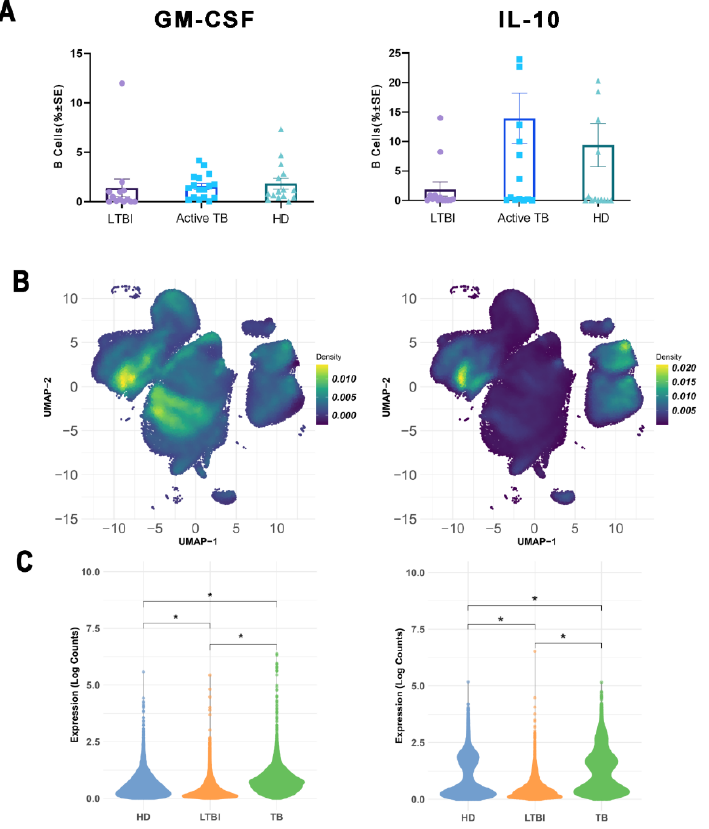
Figure 4. Analysis of GMCSF and IL-10 expression by CD19 + cells among the groups. ( A ) Analysis of GM-CSF (left) and IL10 (right) expression by CD19 + cells among the groups, after Ionomycin and PMA stimulation; each dot represents one individual subject out of 13 LTBI, 17 Active TB, and 15 HD. The scatter dot plots represent the mean and SE of each group. ( B ) UMAP density plots of B cells in stimulation conditions indicate cytokine expression in each relative cluster, dark blue shows no production of GMCSF and IL10, and yellow shows production of GMCSF and IL10. ( C ) Kruskal– Wallis one-way analysis of log 10 counts of GMCSF and IL10 between different conditions in total B cells, * p < 0.05.